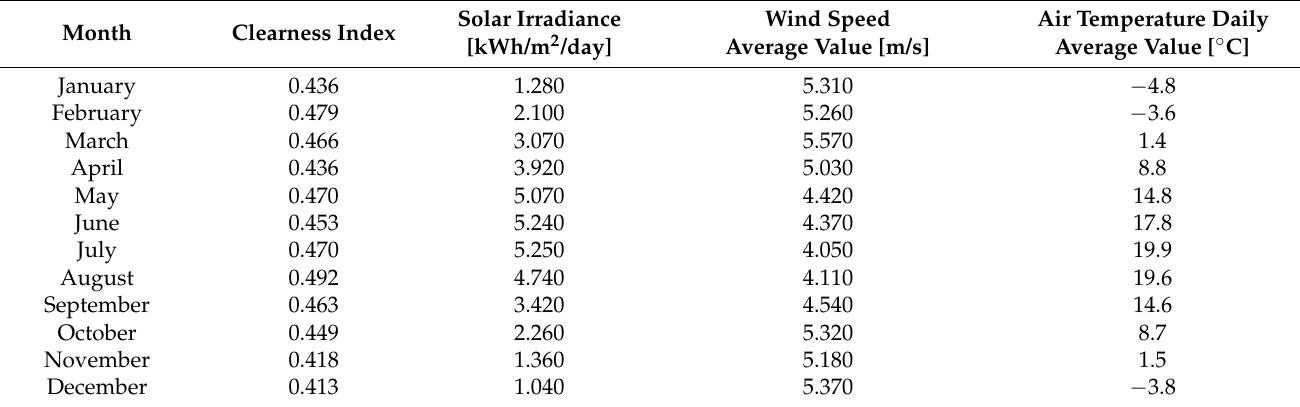
Table 1. Variation in the annual solar irradiance and wind speed for the Suceava County